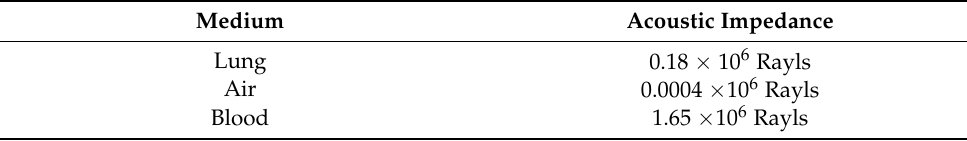
Table 1. Acoustic impedance values of lung, air, and